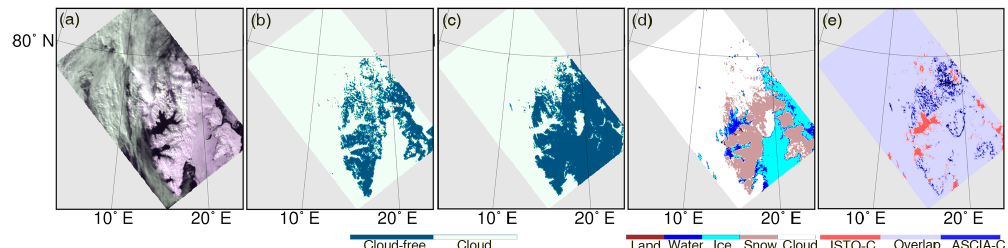
Figure 10. (a) The RGB false-colour image (using 0.67, 0.87 and 0.55µm channels) of AATSR over Svalbard, 3 May 2006; (b) nadir cloud flag from the AATSR L2 product; (c) cloud detection based on the spectral shape of clear snow; (d) cloud detection of ASCIA and (e) the difference between ISTO and ASCIA.